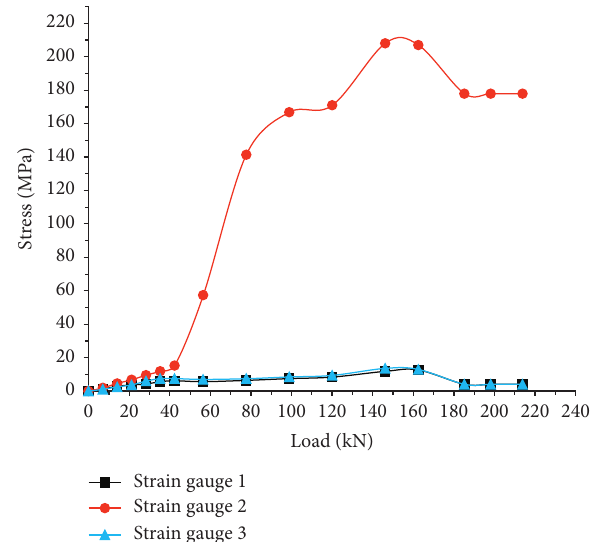
Figure 15: Stress/load curves at different measuring points on the SL-2 tensile LPCSHTHSC rebar.